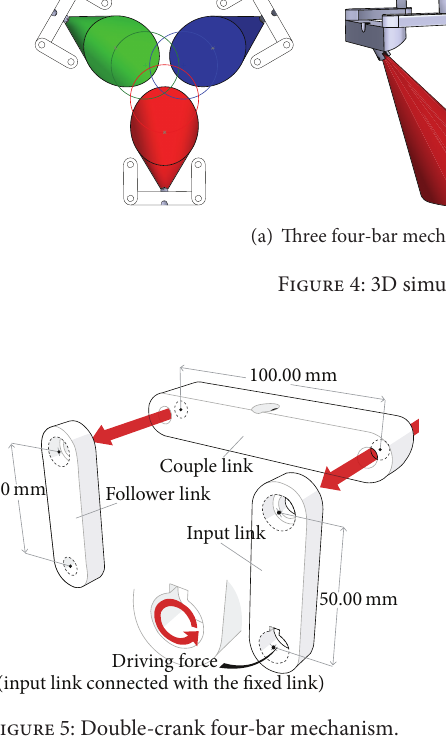
Figure 7: RGB light overlapping